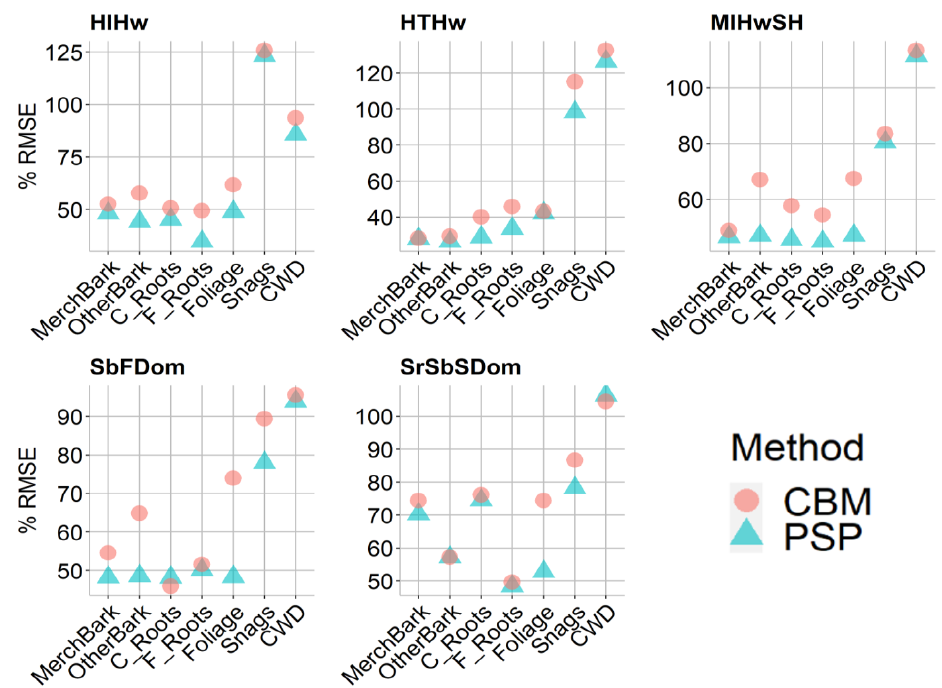
Figure 7. Percent Root Mean Square Error (%RMSE) of both estimation methods against an independent PSP dataset ( n = 100 per forest community) by forest community and carbon pool.